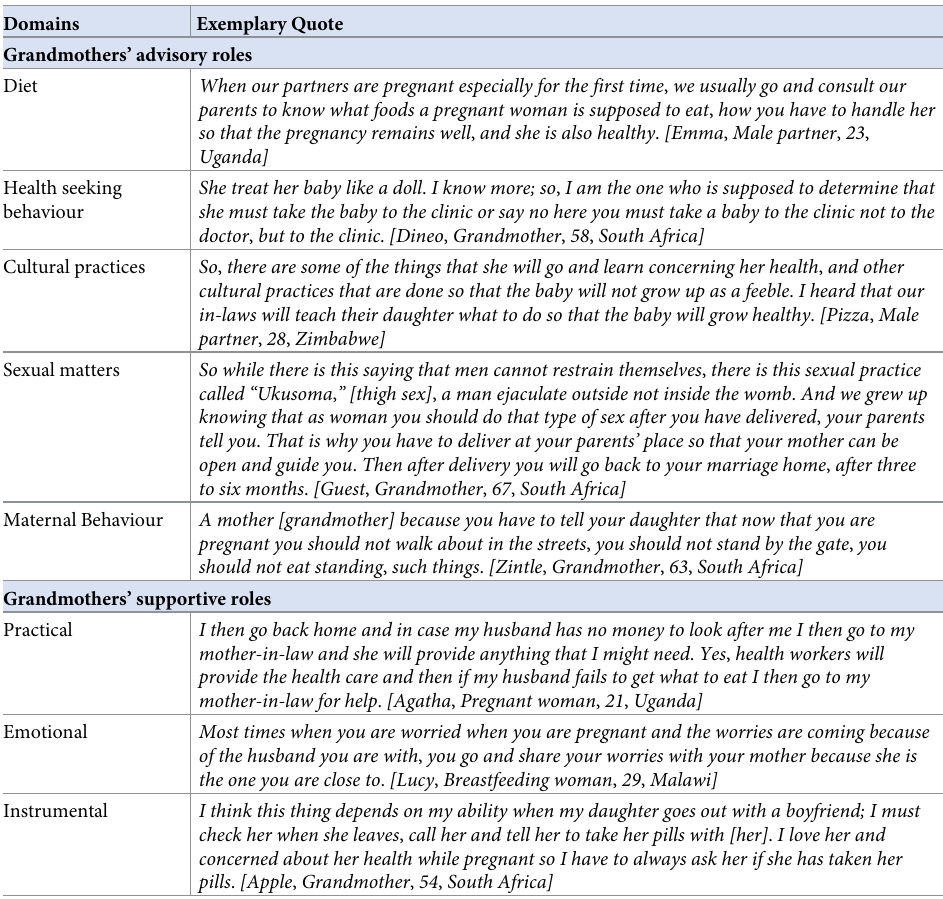
Table 3. Grandmother advice and support provided during pregnancy or breastfeeding as described by partici- pants during